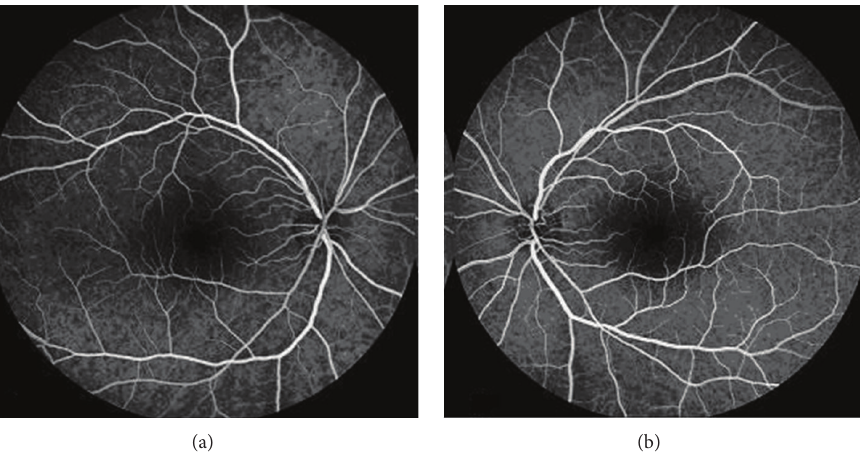
Figure 2: Fluorescein angiography of the right (a) and left (b) eyes nine minutes after injection of fluorescein that revealed the absence of fluorescein leakage typical of cystoid macular edema induced by nicotinic acid in both eyes.